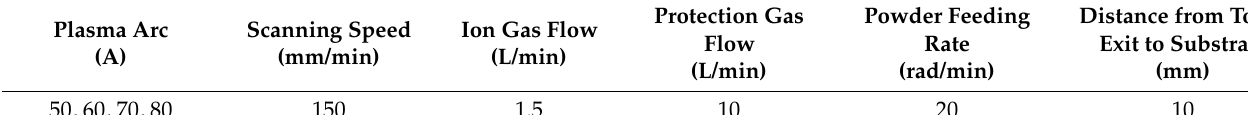
Figure 3. Microstructure of the grey cast iron .